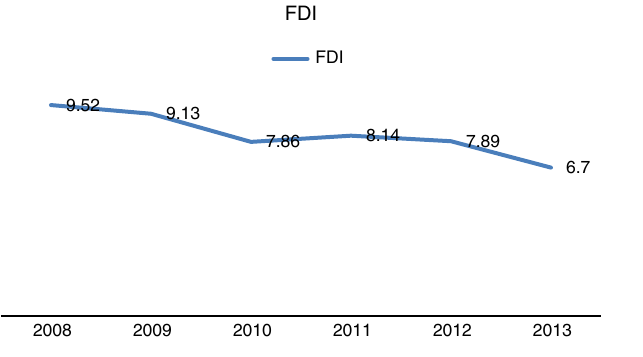
Figure 1. Trend analysis of